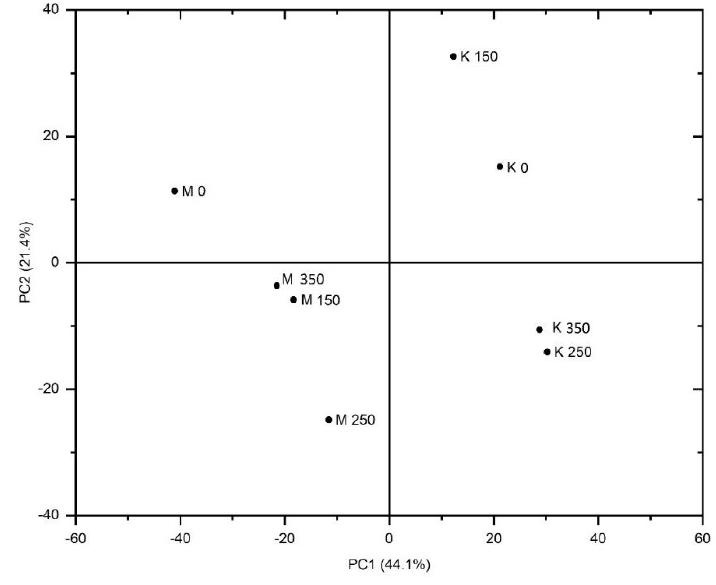
Figure 4. The score plot of PC1 and PC2 for all samples.